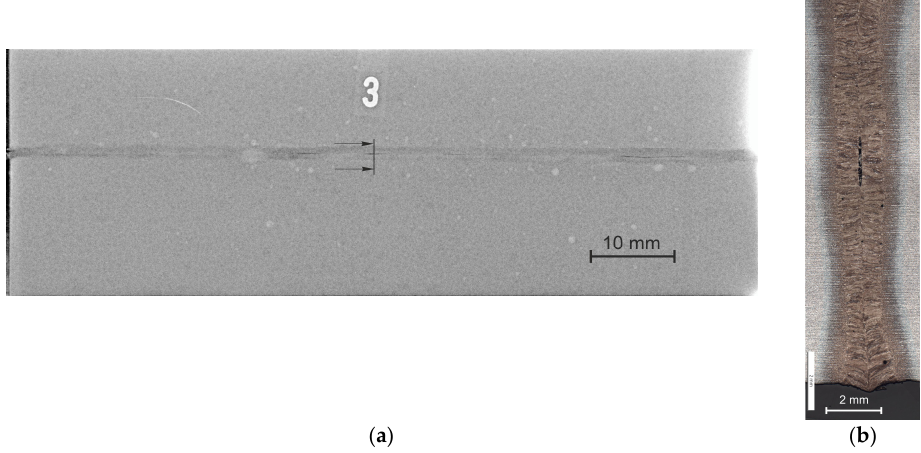
Figure 6. ( a ) Radiographic film of a welded sample. ( b ) Weld cross-section at the crack location.